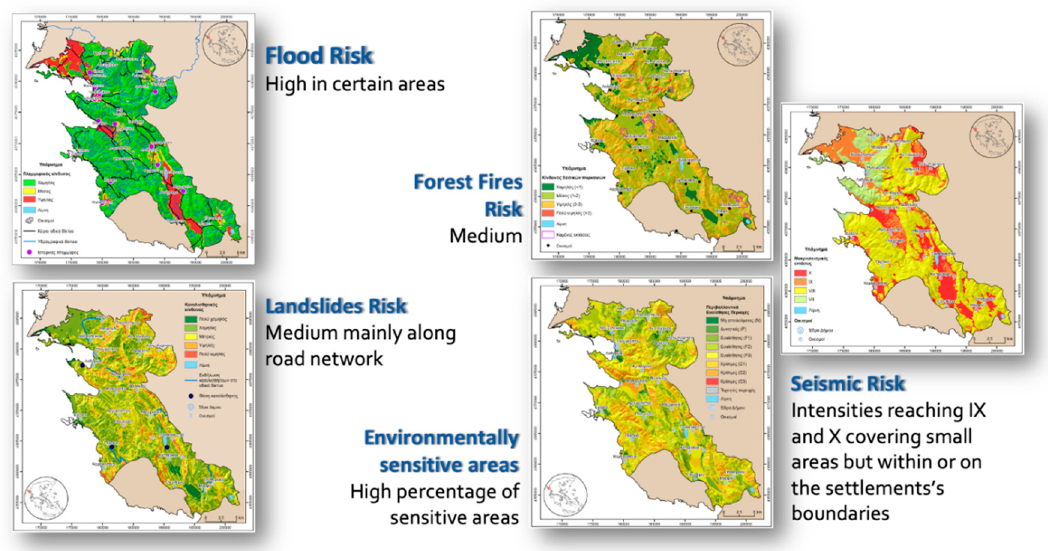
Figure 1. Risk maps for floods, landslides, forest fires, desertification and seismicity covering the Municipality of Igoumenitsa. A color palette ranging from green to red is used to present the risk level from low to high, respectively.